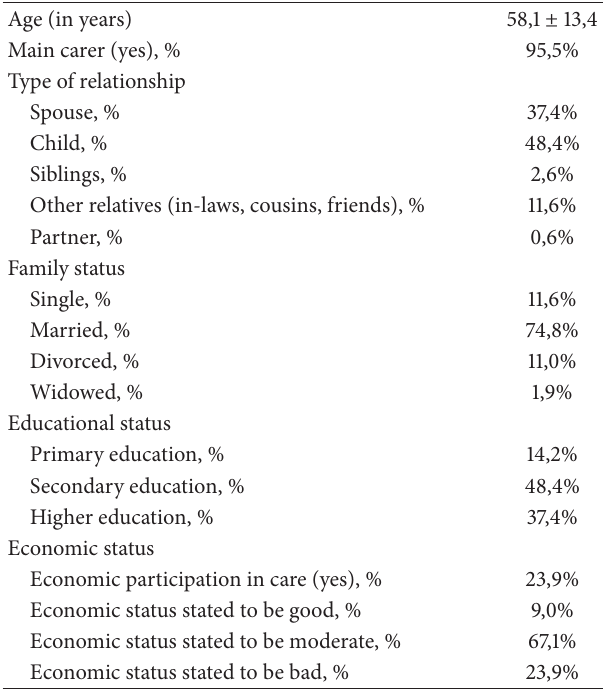
Table 1: Sociodemographic characteristics and financial status of the participants ( n =